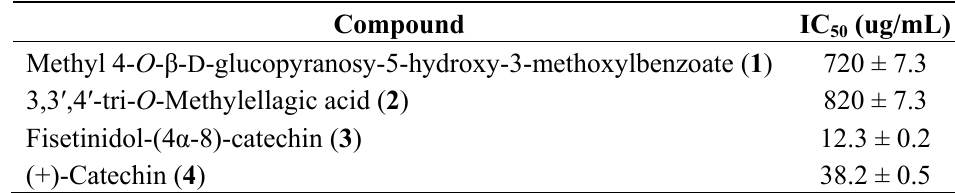
Table 2. The antioxidant assay data of the isolated